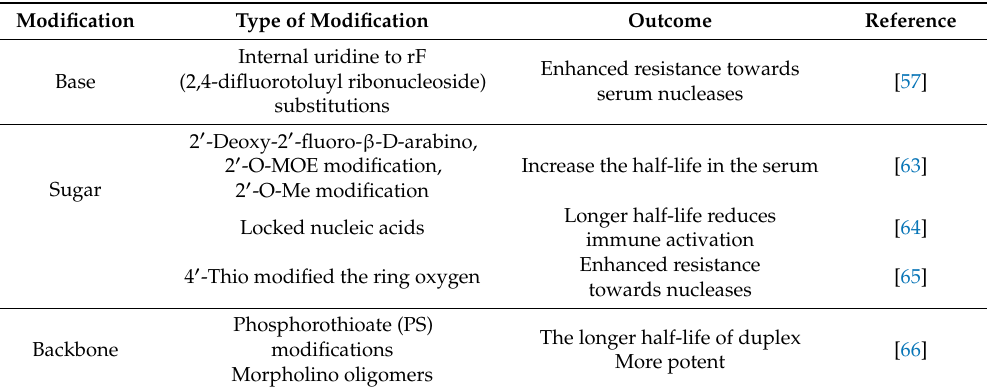
Table 3. Characteristics of siRNA